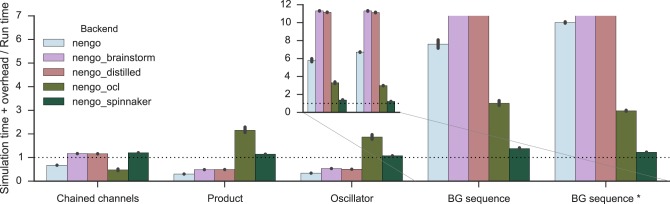
Run speed for each model on each backend. Each bar represents the mean run speed across 50 instances of each model; error bars are bootstrapped 95% confidence intervals. Run speed is measured as the simulation time plus overhead, relative to real time; e.g., a value of two indicates that calling run for a number of seconds takes the model two times that number of real seconds to complete the run call. BG Sequence * refers to the basal ganglia sequence model in which passthrough nodes have been removed.